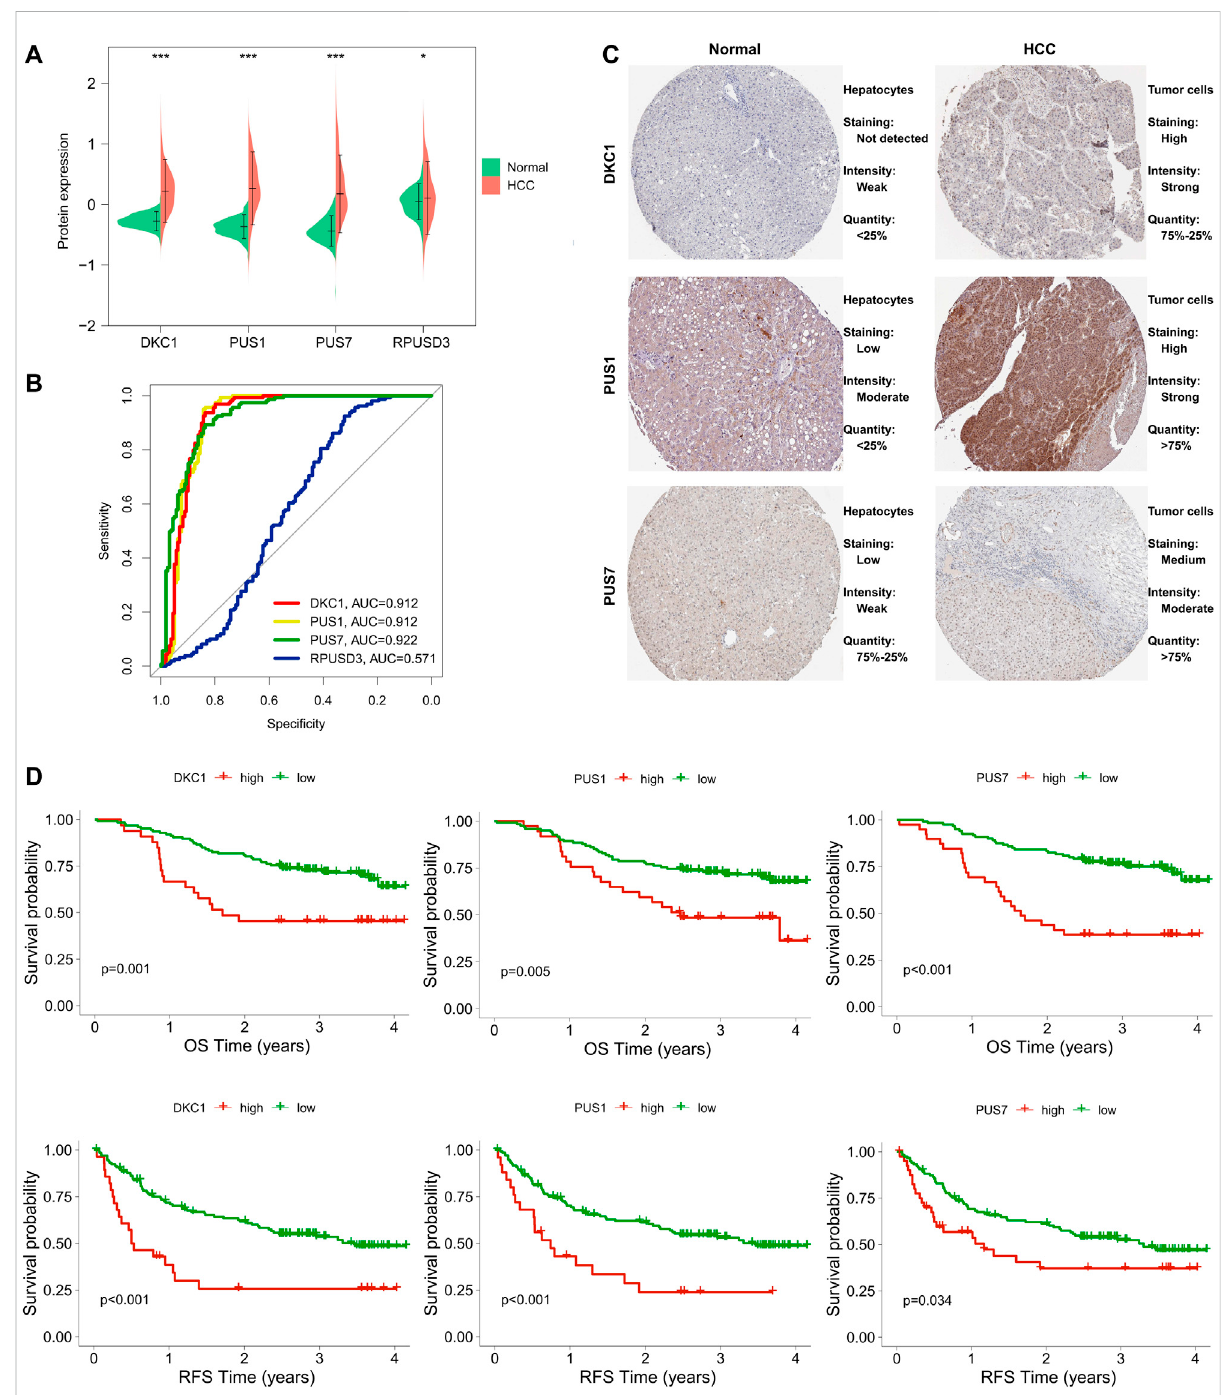
FIGURE 8 Expression levels of PUS proteins in HCC and their diagnostic and prognostic value. (A) Differences in PUS proteins expression between non- cancerous tissues and HCC; (B) ROC curves of PUS proteins expression in HCC; (C) Representative immunohistochemical results of three differentiallyexpressedPUSproteins; (D) K-ManalysisforOSandRFSofHCCpatientsstrati fi edbyproteinexpressionofthreedifferentiallyexpressed PUSs. (* p < 0.05, ** p < 0.01, and *** p <